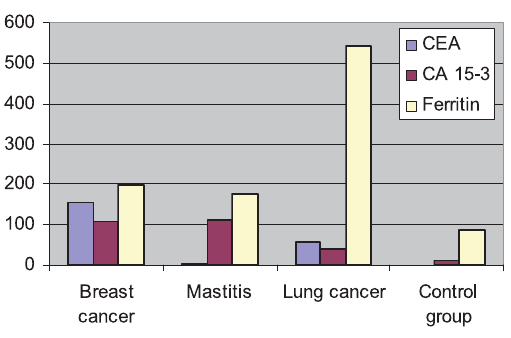
FIGURE 2. The mean concentration of CEA. CA 15-3 and ferritin in patients with tumor and benign disease